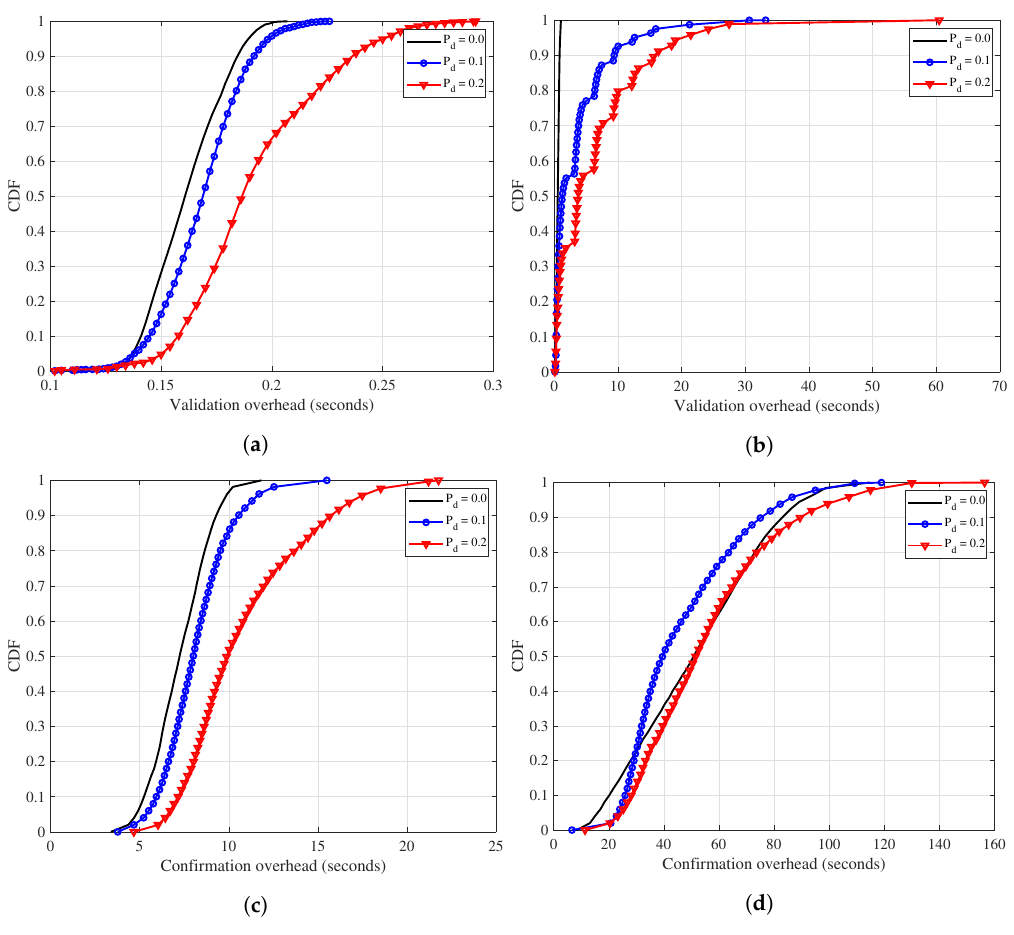
Figure 9. CDF of the validation and confirmation overhead with respect to P d . ( a ) Validation overhead CDF of PowerGraph with respect to P d ; ( b ) Validation overhead CDF of IOTA with respect to P d ; ( c ) Confirmation overhead CDF of PowerGraph with respect to P d ; ( d ) Confirmation overhead CDF of IOTA with respect to P d